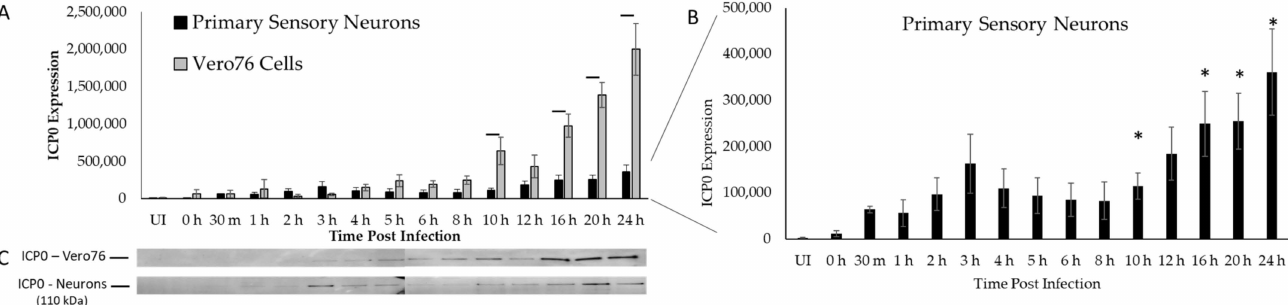
Figure 1. Protein expression profile of ICP0 in Vero 76 cells and primary adult sensory dorsal root ganglion (DRG) neurons ( A ), based on densitometry analysis, normalized to fluorescent detec- tion of total protein per lane using 2,2,2-trichloroethanol (TCE) for visualization and densitometry ( n = 4 independent immunoblots). To show the pattern of expression of ICP0 in sensory neurons over time, the sensory neuron expression data in A is also shown on a modified scale (( B ), note Y-axis). Representative Western blots are shown ( C ). UI = uninfected neurons, 0 h = immediately upon inoculation. Error bars = SEM. Bars ( A ) and asterisks ( B ) = statistically significant difference between Vero76 cells and primary sensory neurons ( p <